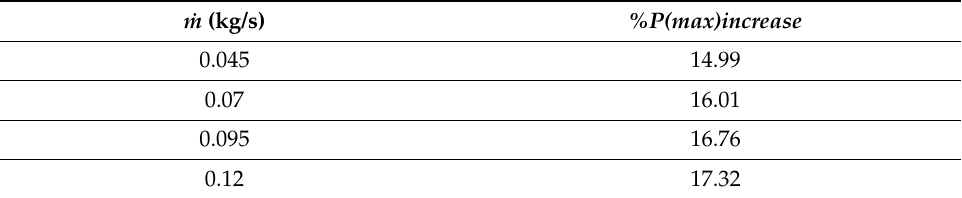
Table 5. Effect of mass flow rate on economic factors at c = 2%, I = 1000 W/m 2 , h sl = 107.1 kJ/kg, N = 8, and H = 30 mm.